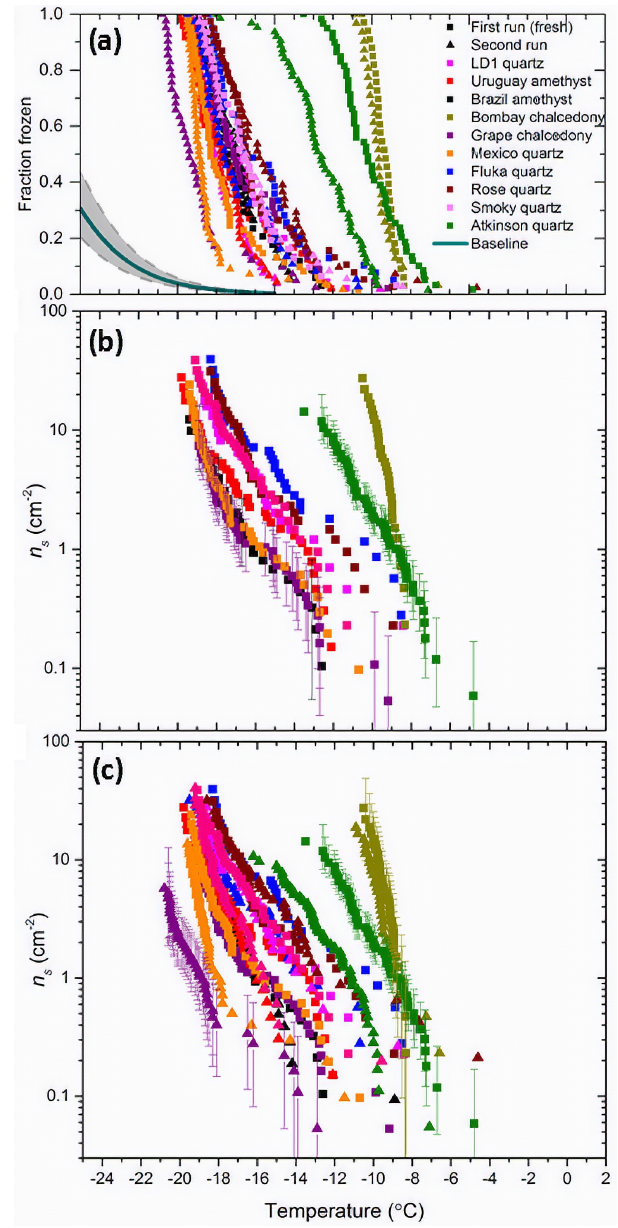
Figure 3. Fraction frozen and active site densities for 10 quartz sus- pensions (1wt%). (a) The fraction frozen versus temperature for the different quartz samples investigated in this study. The range of freezing for the baseline is highlighted in the grey-shaded region (Umo et al., 2015). (b) The active site density ( n s ) for the range of quartz samples in this study. In this plot only the first run of each sample is displayed. These samples are considered to be fresh as they have only spent roughly 10min in suspension. (c) The active site density ( n s ) versus temperature for the quartz samples on their initial runs and their corresponding second runs. The second runs were carried out roughly an hour after the first run. A sample of the error bars is shown in Fig. 3b and